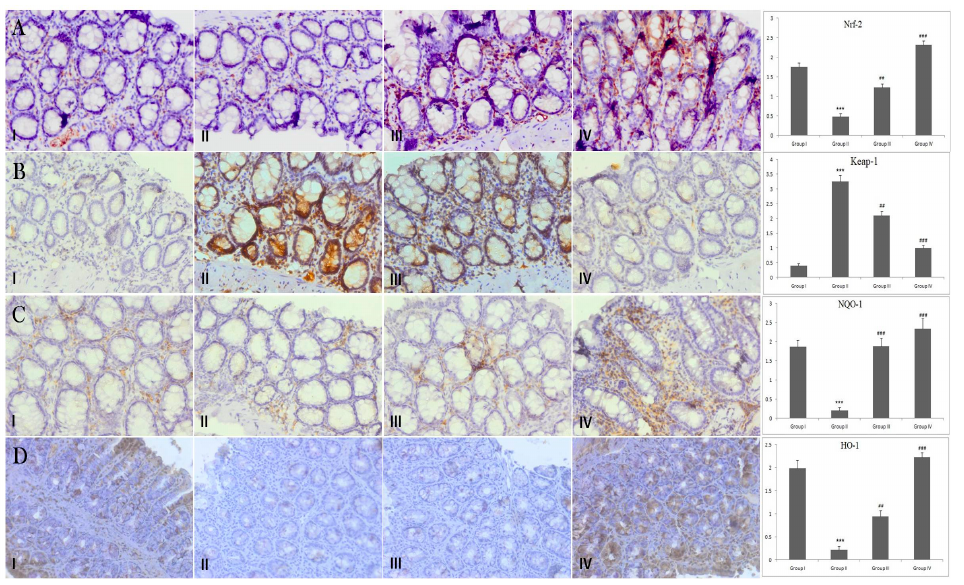
Figure 4. Effect of piperine treatment on Nrf-2, Keap-1, NQO-1 and HO-1expression. Photomicrographs of colon sections depicting immunohistochemical analyses. Adjacent to photomicrographs are four panels which show quantitative evaluation of Nrf-2, Keap-1, NQO-1 and HO-1 expression immunostaining. Significant differences were indicated by *** p < 0.001 when compared with group I and ( ## p < 0.01), ( ### p < 0.001) when compared with group II ( A ) Brown color indicates specific immunostaining of Nrf-2, and light blue color indicates counter-staining by hematoxylin. The colonic section of DMH-administered group-II has decreased immunopositive staining of Nrf-2, as indicated by brown color, as compared to control group-I, while treatment of Piperine (30 and 60 mg/kg b. wt.) in groups-III and IV increased Nrf-2 compared to group II. Piperine significantly activated Nrf-2 in group III and IV, respectively, ( ## p < 0.01) and ( ### p < 0.001), when compared with DMH-administered group-II. ( B ) Photomicrographs of colon sections depicting immunohistochemical analyses; brown color indicates specific immunostaining of Keap-1 and light blue color indicates counter staining by hematoxylin. The colonic section of DMH-administered group-II has more Keap-1, as indicated by brown color, as compared to control group I, while treatment of piperine (30 and 60 mg/kg b. wt.) in groups III and IV reduced Keap-1 immunopositive as compared to group II. Piperine significantly suppressed Keap-1 in group III and IV, respectively, ( ## p < 0.01) and ( ### p < 0.001), when compared with DMH-administered group-II. ( C ) Photomicrographs of colon sections depicting immunohistochemical analyses; brown color indicates specific immunostaining of NQO-1 and light blue color indicates counter-staining by hematoxylin. The colonic section of DMH-administered group-II has decreased immunopositive staining of NQO-1, as indicated by brown color, as compared to control group I, while treatment of piperine (30 and 60 mg/kg b. wt.) in groups III and IV increased NQO-1 as compared to group II . Piperine significantly upregulated NQO-1 in group III and IV, respectively, ( ### p < 0.001) when compared with DMH-administered group-II. ( D ) Photomicrographs of colon sections depicting immunohistochemical analyses; brown color indicates specific immunostaining of HO-1 and light blue color indicates counter-staining by hematoxylin. The colonic section of DMH-administered group-II has decreased immunopositive staining of HO-1, as indicated by brown color, as compared to control group I while treatment of piperine (30 and 60 mg/kg b. wt.) in groups III and IV increased HO-1 as compared to group II. Piperine significantly upregulated HO-1 in group III and IV, respectively, ( ## p < 0.01) and ( ### p < 0.001), when compared with DMH-administered group-II. All images have original magnification of 40× ( n = 10).